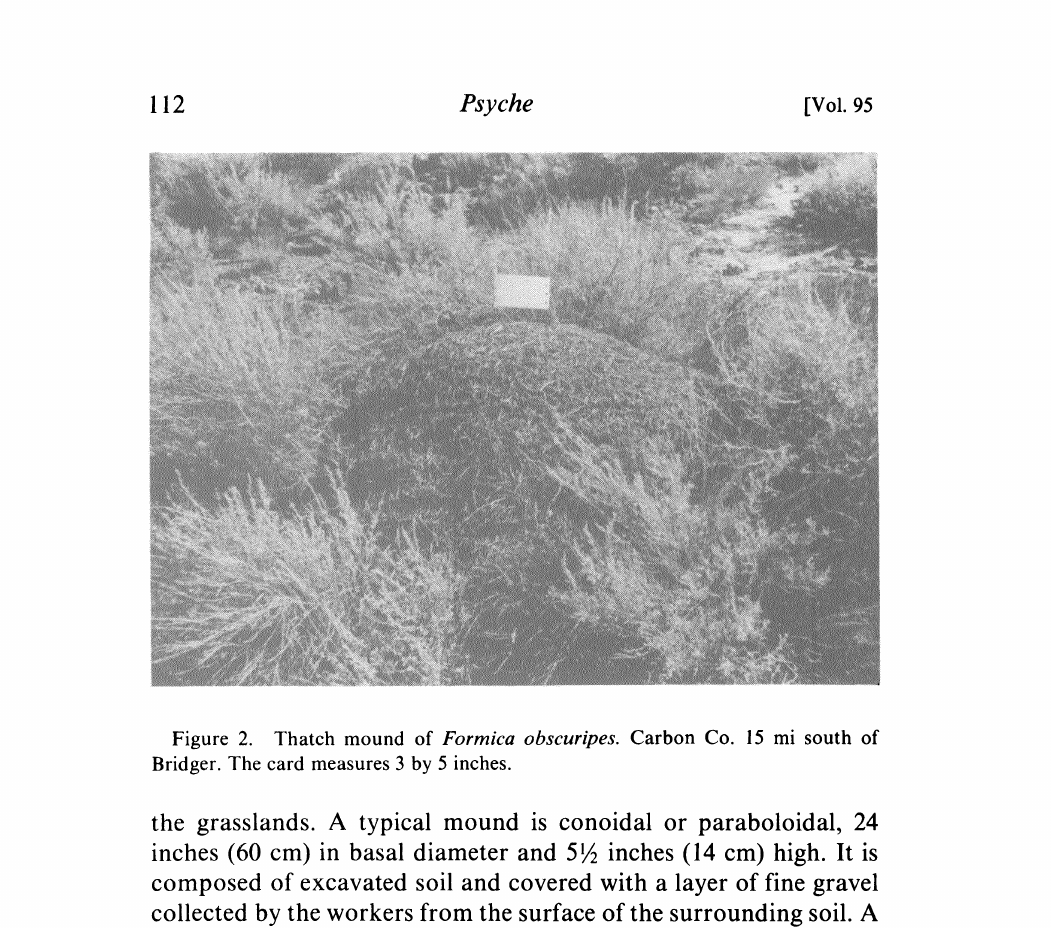
Figure 2. Thatch mound of Formica obscuripes. Carbon Co. 15 mi south of Bridger. The card measures 3 by 5